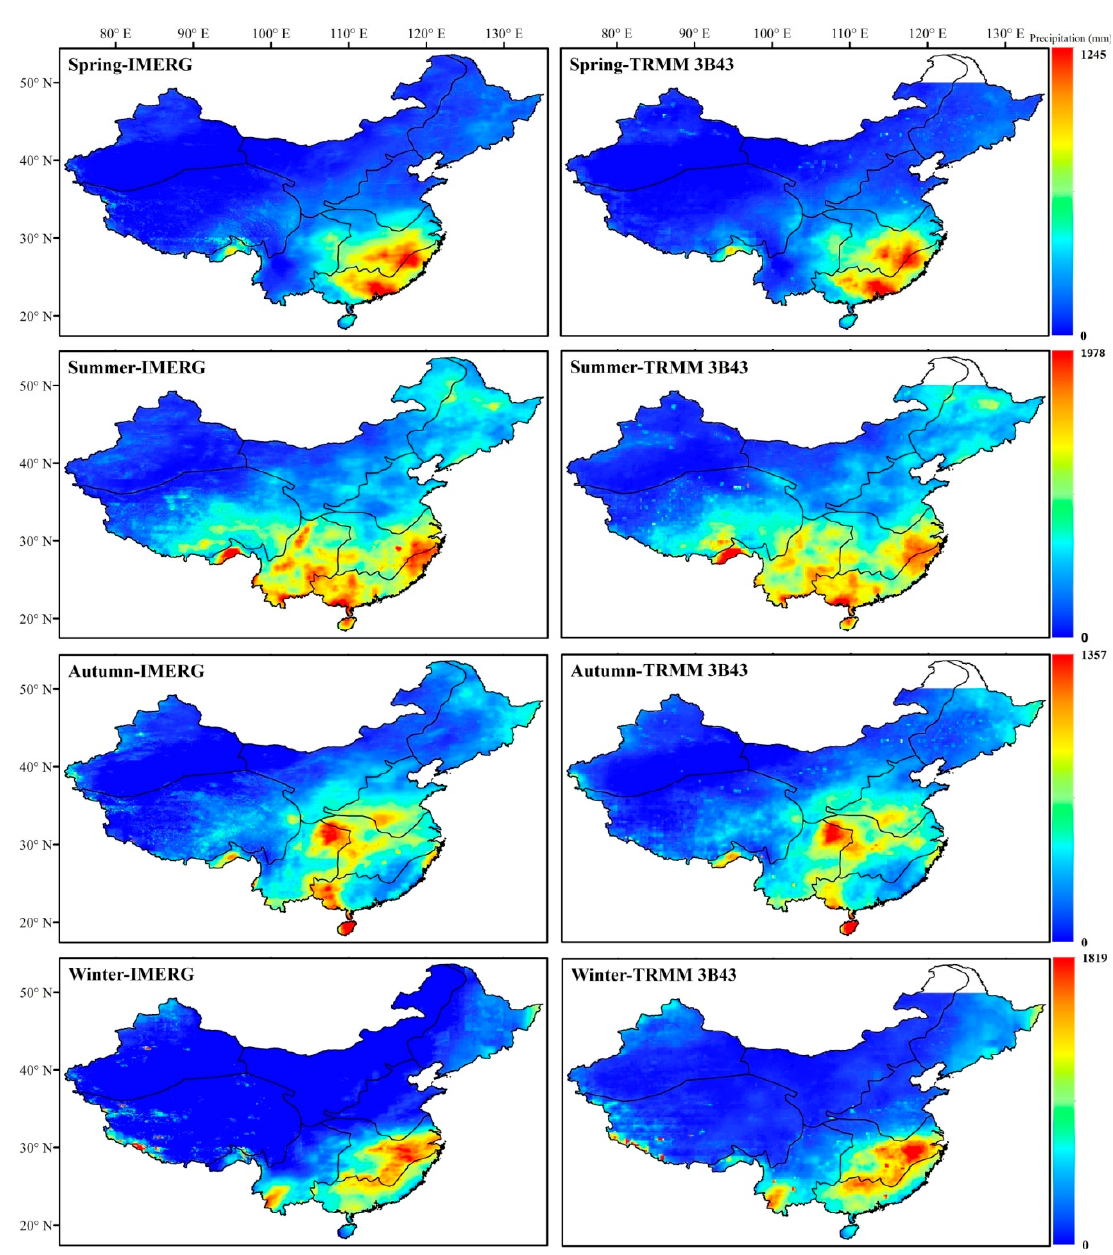
Figure 5. Seasonal precipitation estimates derived from IMERG and TRMM 3B43 products over Mainland China.